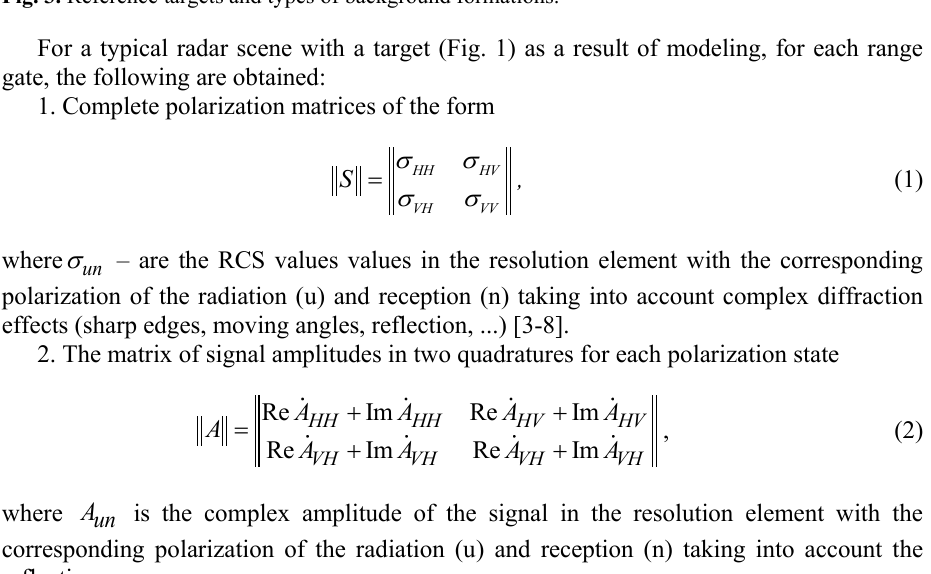
Fig. 3. Reference targets and types of background